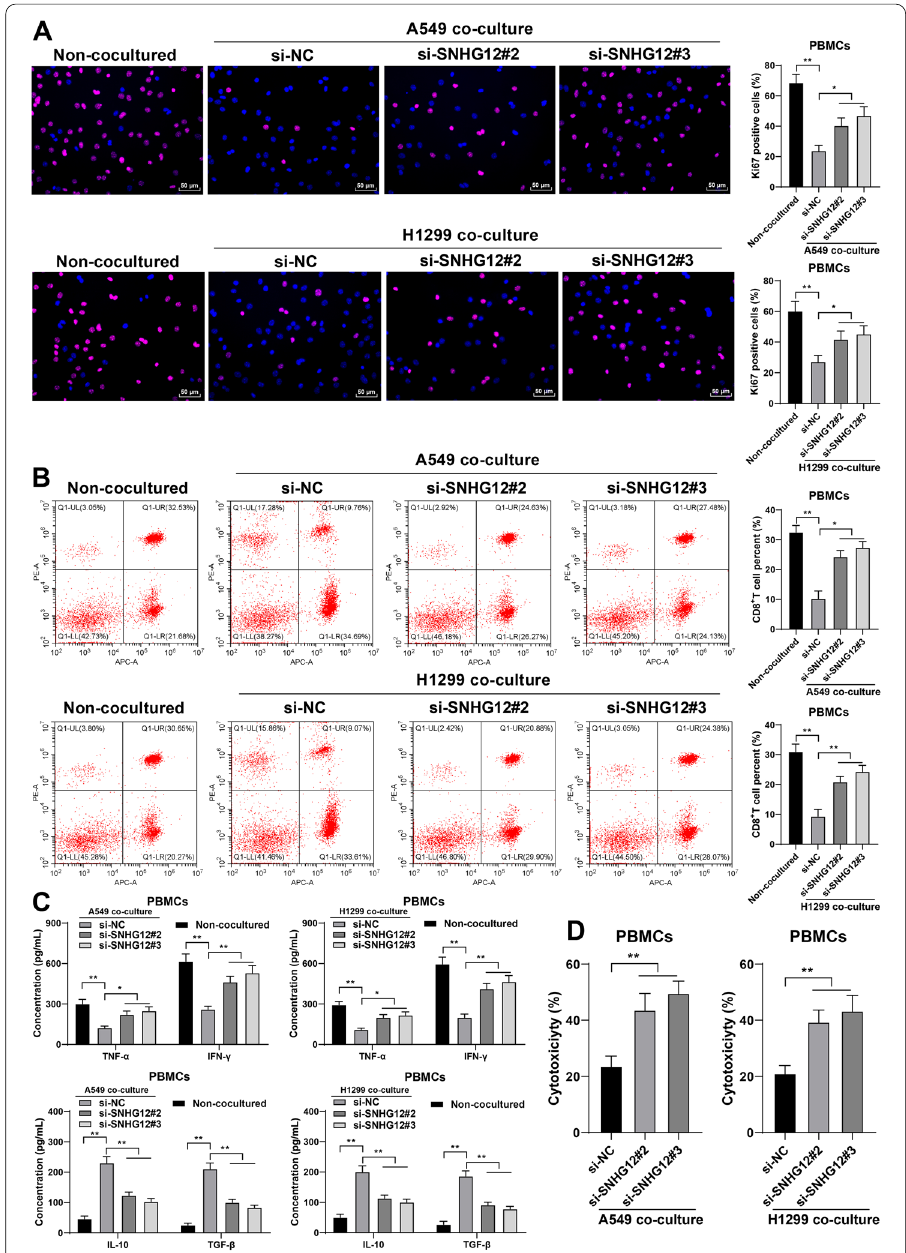
Fig. 3 lncRNA SNHG12 downregulation blocked the immune escape of NSCLC. A549 or H1299 cells in different treatment groups were co-cultured with isolated PBMCs. A PBMC proliferation was observed via Ki67 staining; B percentage of CD8 + T cells in PBMCs was determined via flow cytometry; C concentrations of TNF-α, IFN-γ, IL-10, and TGF-β were determined via ELISA; D cytotoxicity of PBMCs was detected via LDH cytotoxicity assay. Cell experiments were performed in triplicates, * P < 0.05, ** P < 0.01. Data were represented as mean standard deviation. Multigroup comparisons in A , B , and D were analyzed using one-way ANOVA ± and in C were analyzed using two-way ANOVA, followed by Tukey’s multiple comparison